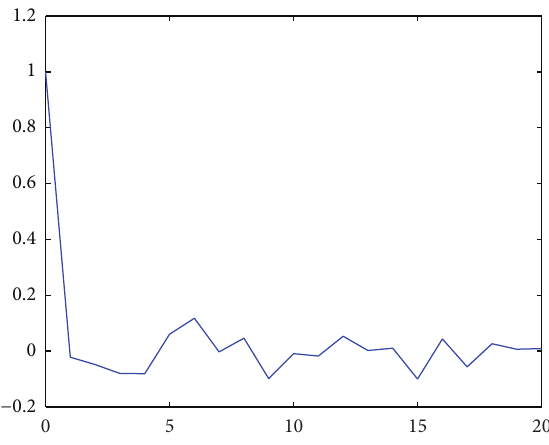
Figure 5: Residual independence series